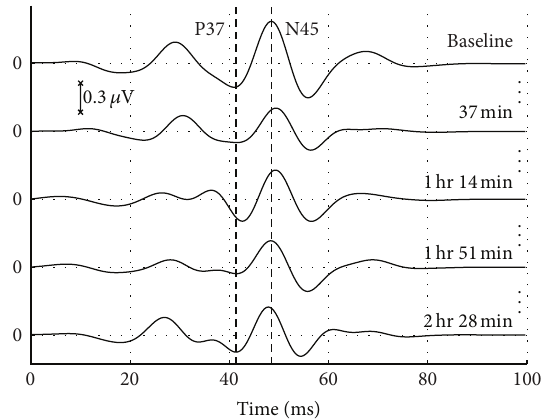
Figure 4: Comparisons of SSEP that were extracted through the surgery with the baseline SSEP at five stages during the surgery of patient number